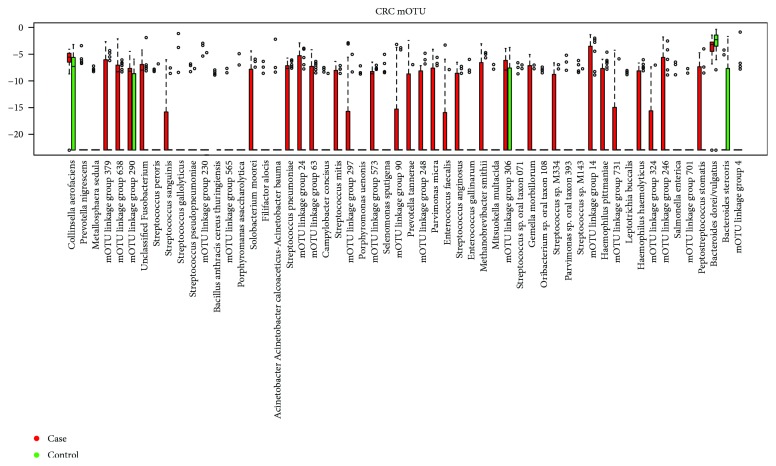
Control versus colorectal cancer case marker in mOTU.